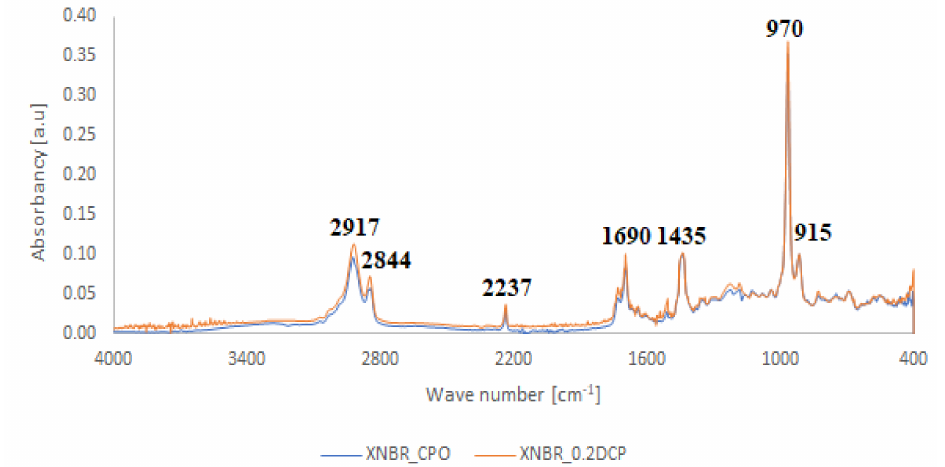
Figure 6. Influence of the peroxide curing system modification on the hardness of the rubber vulcan-